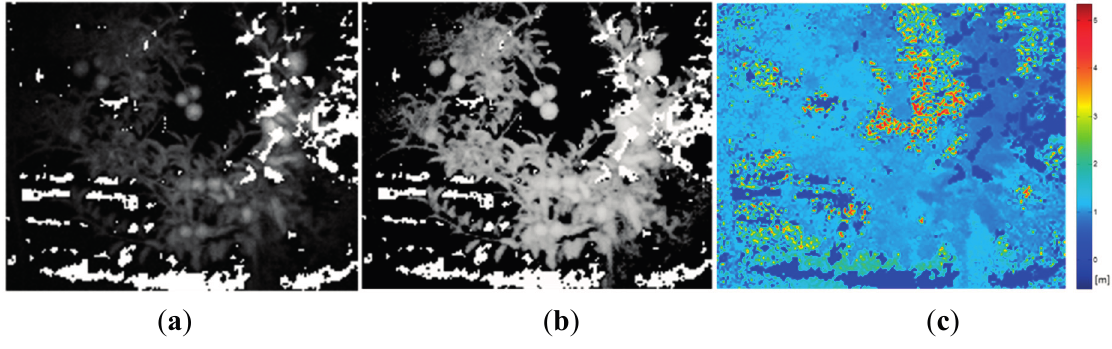
Figure 10. Data acquired with the TOF camera – Apple crop. ( a ) TOF amplitude data; ( b ) TOF camera confidence map; ( c ) Z-axis range data acquired with the TOF camera.